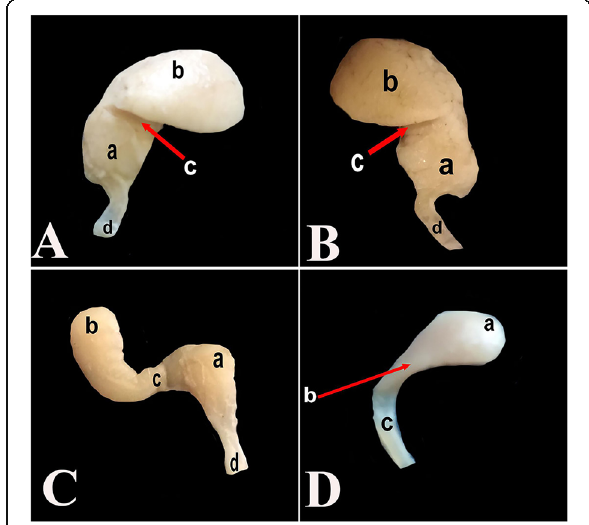
color of the glands was ranged from pinkish white to reddish brown. One excretory duct of the all examined glands arisen from anterior extremity then passed to open in the medial part of the conjunctival membrane (Figs. 2 and 3).